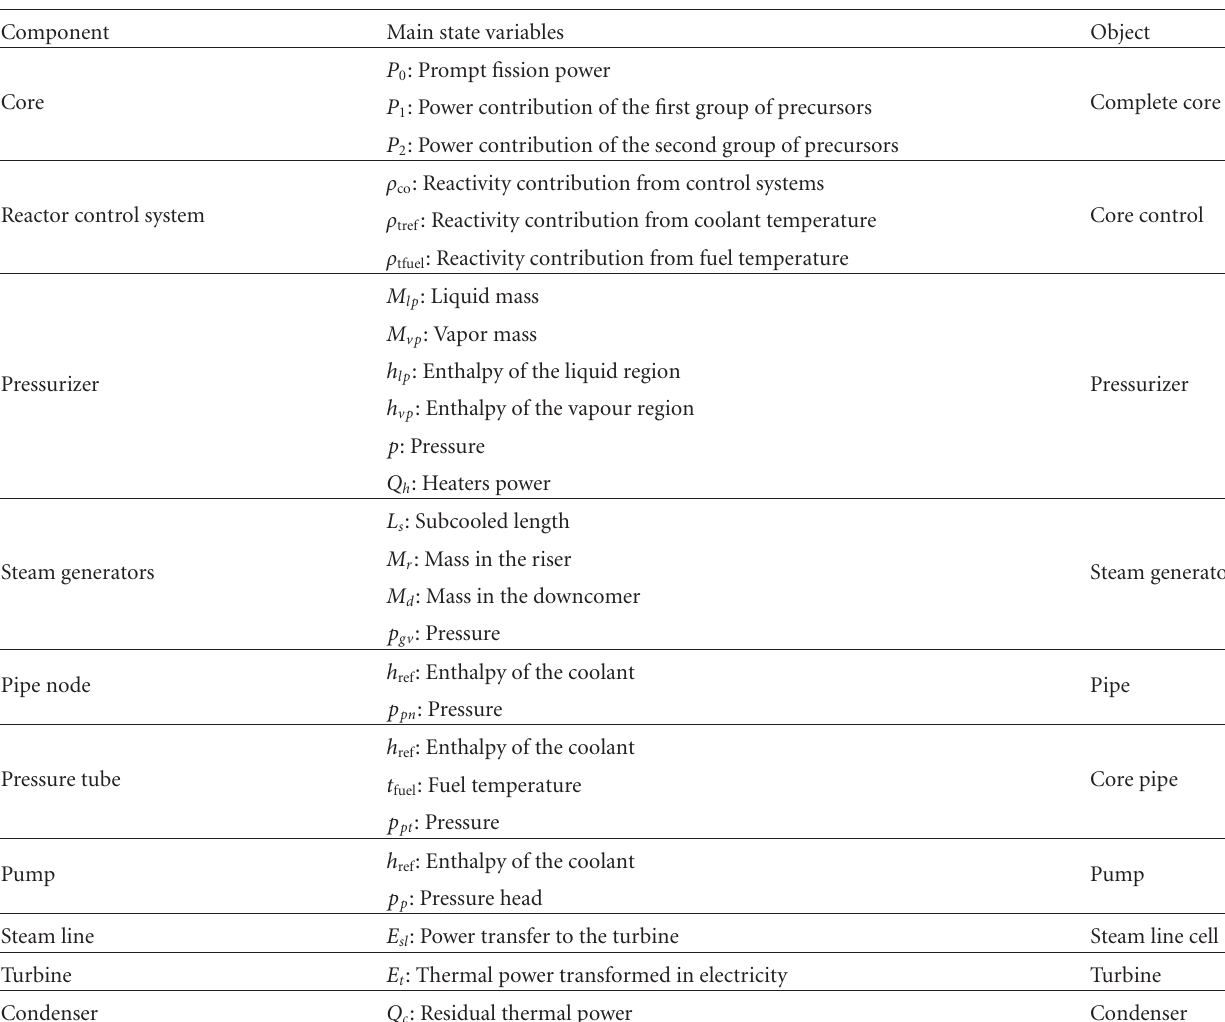
Table 1: List of components and variables of